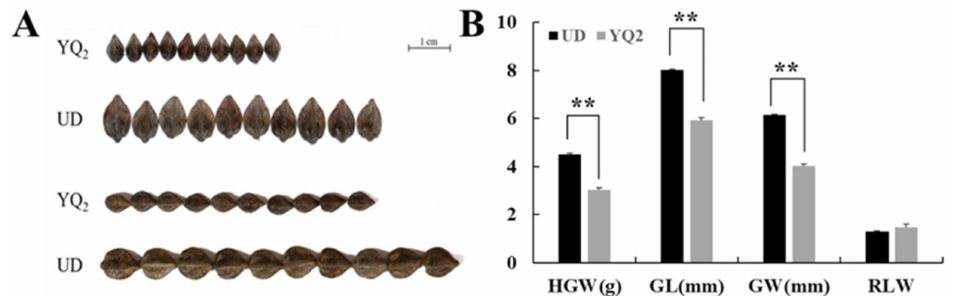
Figure 1. Comparison of mature grain size of parents. ( A ) Phenotypic observation. ( B ) Statistical analysis. GL for grain length, GW for grain width, HGW for hundred-grain weight, RLW for ratio of length-width. ** Significances with the probability levels of 0.01.